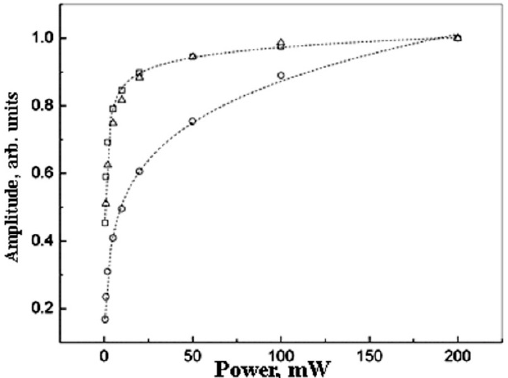
Figure 4. The saturation effect for the normalized EPR amplitude for Pd nanoparticles for different metal content: 5 wt.% (circles ○ ),10 wt.% (squares □ ), and 20 wt.% (triangles ∆ ). The dot lines show the fitting by formulae (3).